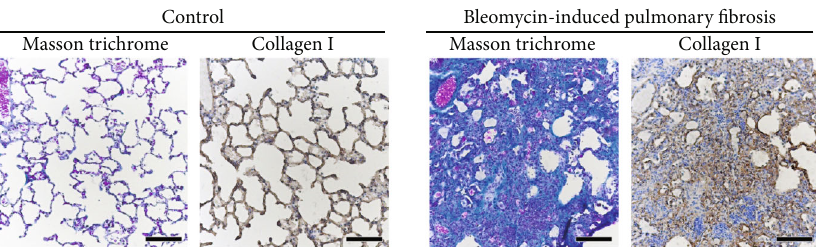
Figure 2: Pathologic features of the fi brotic lungs of mice with bleomycin-induced pulmonary fi brosis. After 14 days of bleomycin administration, frozen serial lung sections were prepared. Masson ’ s trichrome staining and immunohistochemical staining were performed for the pathologic features and presence of collagen I, respectively. Scale bar is 100 μ m.